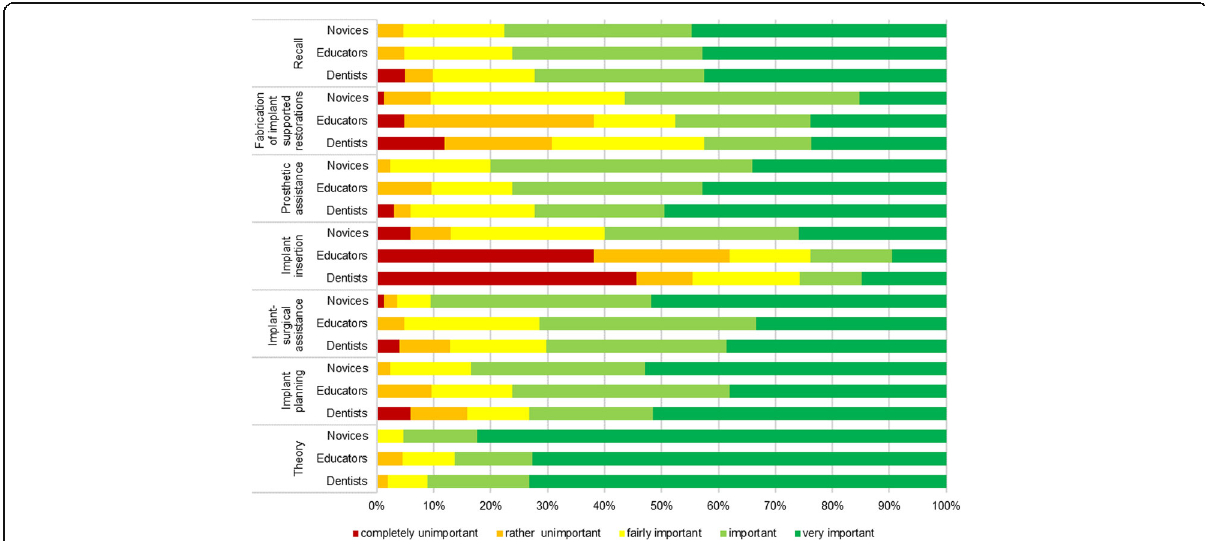
Fig. 6 The importance of being taught content about implant dentistry, as ascribed by participants. The participants scored each learning category as “ completely unimportant, ” “ rather unimportant, ” “ fairly important, ” “ important, ” or “ very important